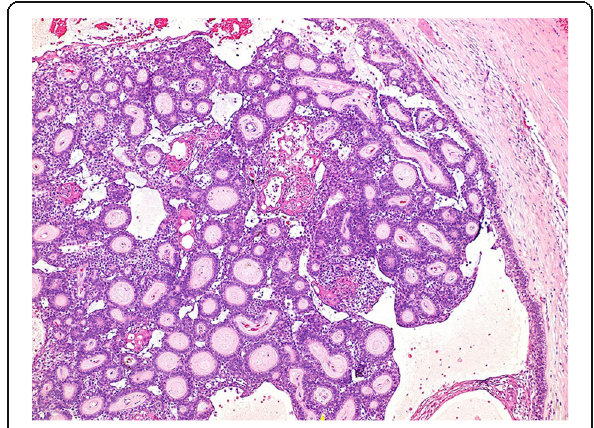
Fig. 3 Unicystic ameloblastoma showing intraluminal proliferation in follicular and acanthomatous pattern (Original Magnification ×